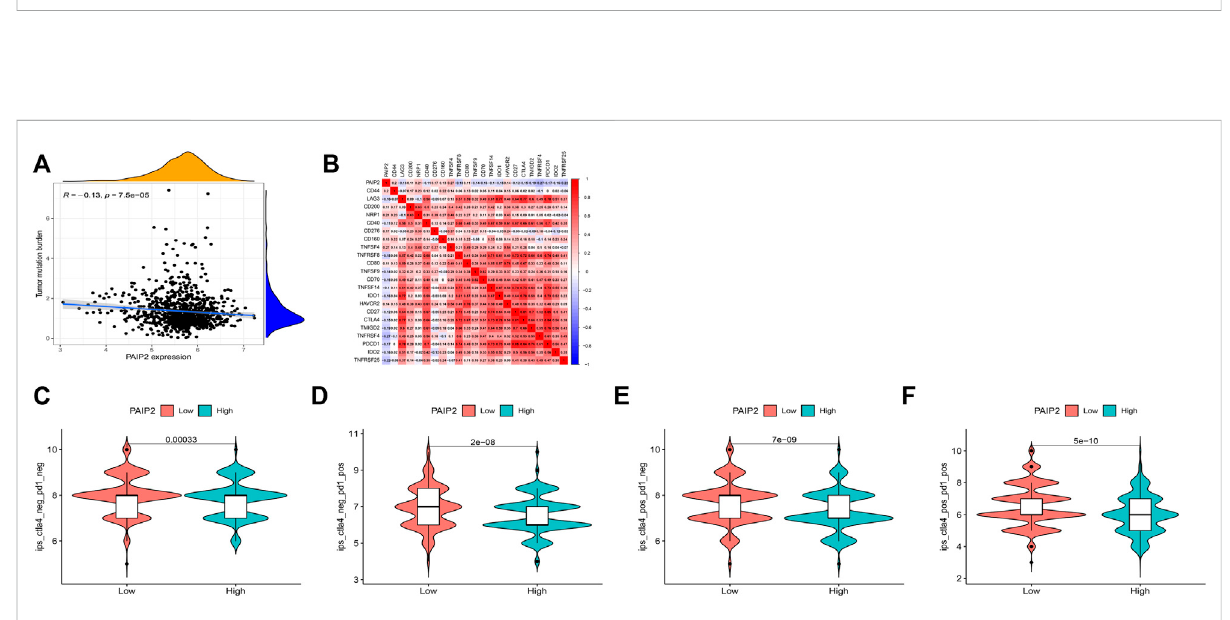
Correlation betweenPAIP2andtumorimmunity. (A) :TheexpressionofPAIP2wassigni fi cantly negativelycorrelatedwithTMBinbreastcancer. (B) : PAIP2 was signi fi cantly associated with 22 immune checkpoint genes in breast cancer (bule represents a negative correlation, red represents a negative correlation). (C – F) : The IPS of low PAIP2 expression group was higher than that of high PAIP2 expression